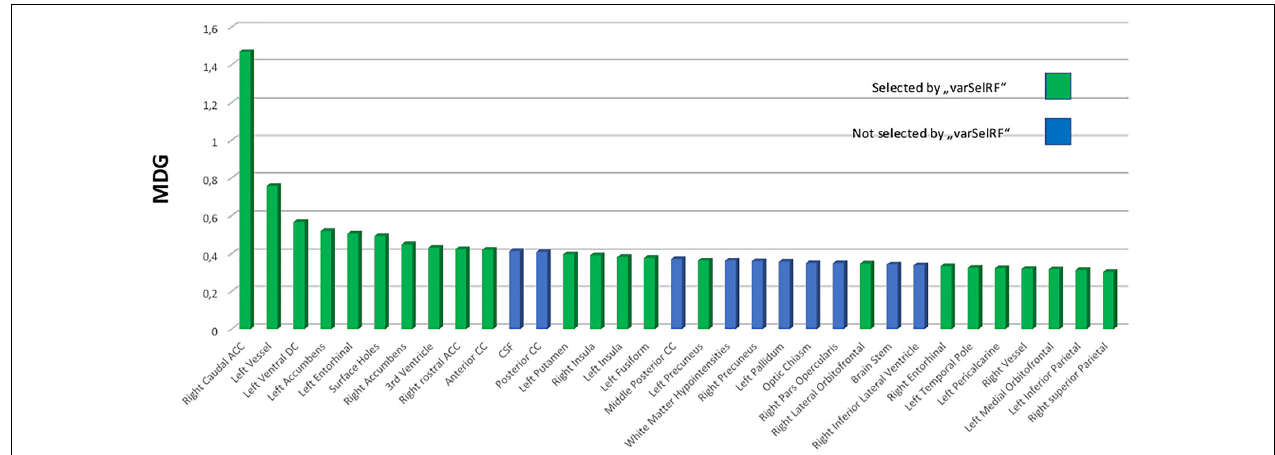
FIGURE 3 | Variable importance measurement from RF by mean decrease in Gini (MDG) for the total data set ( n = 49). The 25% top scoring out of all 134 predictors are portrayed and ordered by declining contribution to prediction quality to the RF model. Green coloring indicates that these predictors were selected among the most effective predictors for the “National Institute on Aging-Alzheimer’s Association” score for neuropathological change by backward variable selection performed with the “varSelRF” algorithm for the statistical software “R.” RF, RandomForest; MDG, mean decrease in Gini index; CC, corpus callosum; DC,